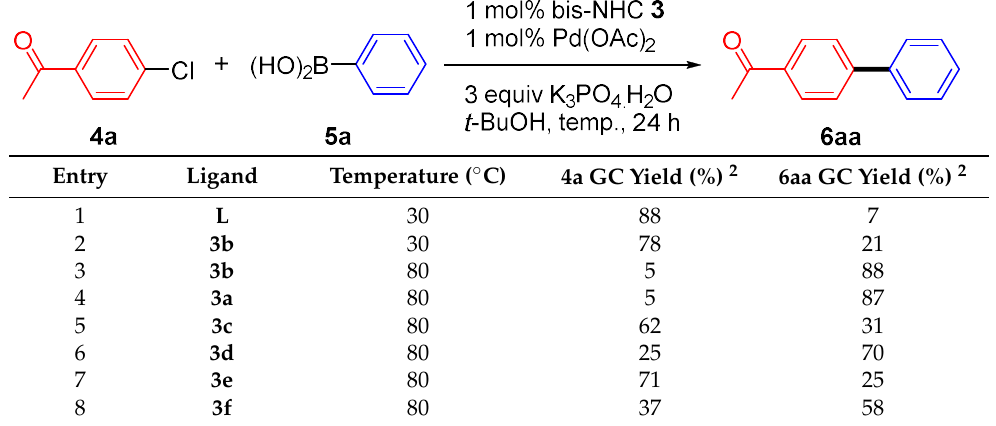
Table 2. Optimization of reaction conditions 1